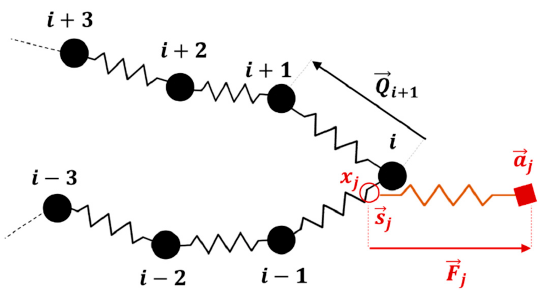
Figure 8. Trapping of slip-spring in the kinked region between three beads that define the folded area. The anchoring point ( a j ) moves affinely with the flow, while the position of the slip-link on the chain, determined by Equations (8) and (10), oscillates between spring 𝑄(cid:4652)⃗ (cid:3036) and 𝑄(cid:4652)⃗ (cid:3036)(cid:2878)(cid:2869) .